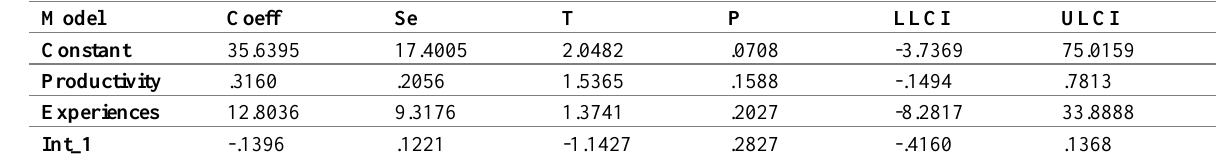
Table 12: Results of Moderation Effect Using Hayes Process Macro (Model 1)